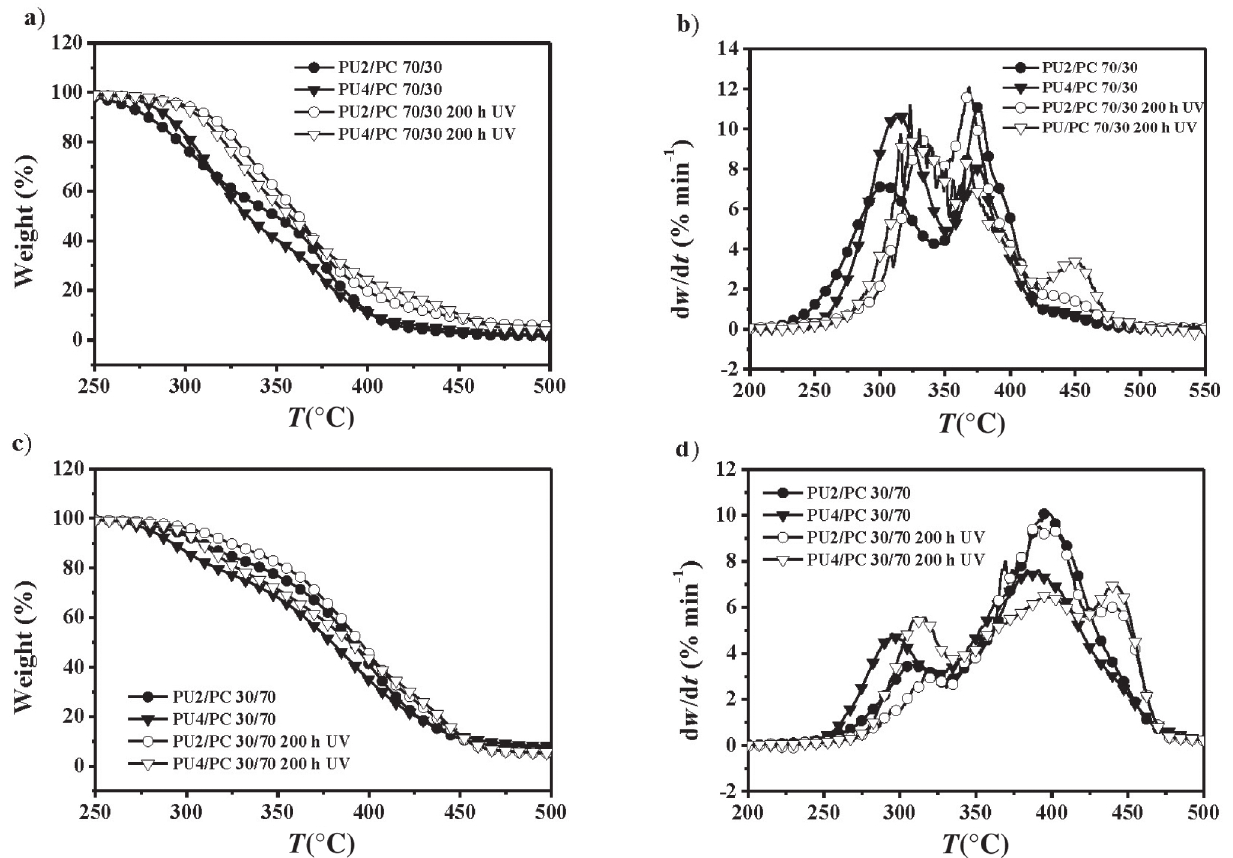
Fig. 7 – TG and DTG curves of: a) and b) Pu/Pc 70/30 blends, and c) and d) 30/70 blends before and after uV